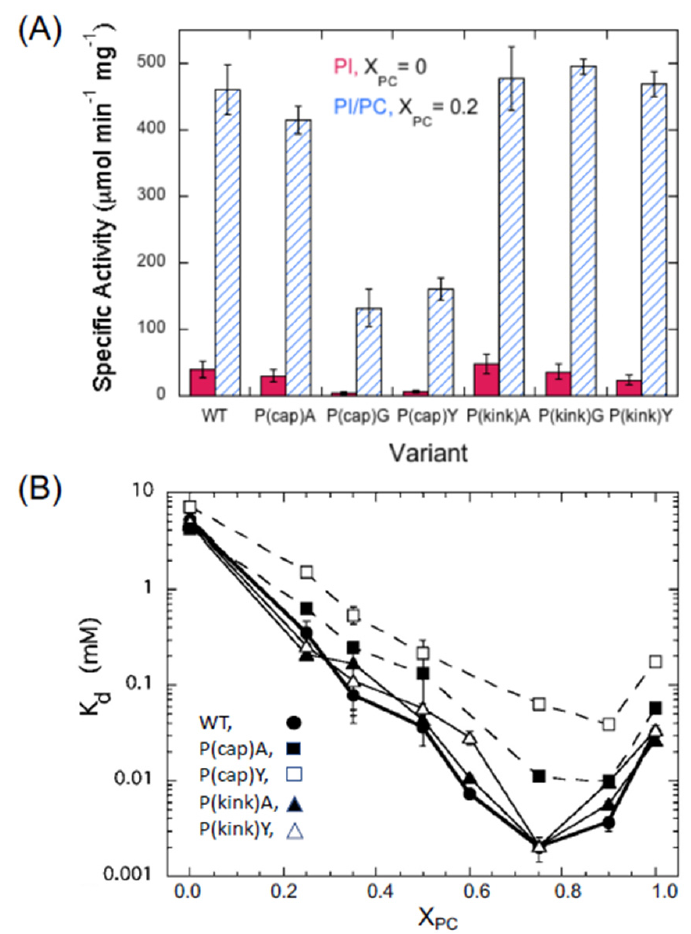
Figure 9. Bt PI-PLC P(cap) and P(kink) specific activities and apparent K d values for SUVs. ( A ) Specific activities for X PC = 0.0 (8 mM PI) and X PC = 0.2 (8 mM PI/2 mM PC). ( B ) PI-PLC binding to DOPG/POPC SUVs as a function of X PC . Part ( A ) is modified, and part ( B ) is reprinted with permis- sion from Cheng et al. Biophys. J. 2013, 104,185–195. Copyright 2013, Elsevier.